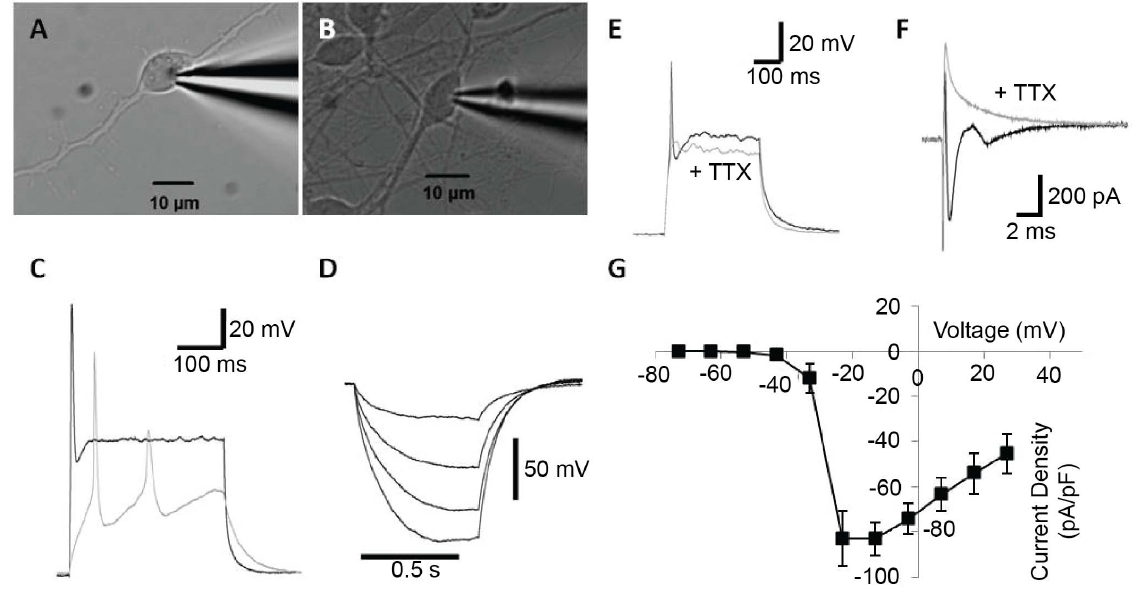
Figure 1. Firing properties of neurons derived from FA iPS cells. ( A – B ). Patch-clamp recordings were made from iPS cells displaying an ovoid soma and bipolar processes. ( C ). Action potentials were activated in response to membrane depolarization. In the example shown here, multiple action potentials are observed at threshold (gray), whilst a single spike occurs in response to supra threshold stimulation (black). ( D ). Negative current injection resulted in membrane hyperpolarisation, without the addition of a depolarizing sag or rebound action potentials at stimulus offset. ( E ). Action potentials were blocked by addition of the sodium channel antagonist TTX (gray). ( F ). In voltage-clamp recordings, the transient inward current observed during membrane depolarization (black) was abolished in the presence of TTX (gray). ( G ). I–V curve demonstrating the voltage- dependence of the TTX-sensitive sodium current.